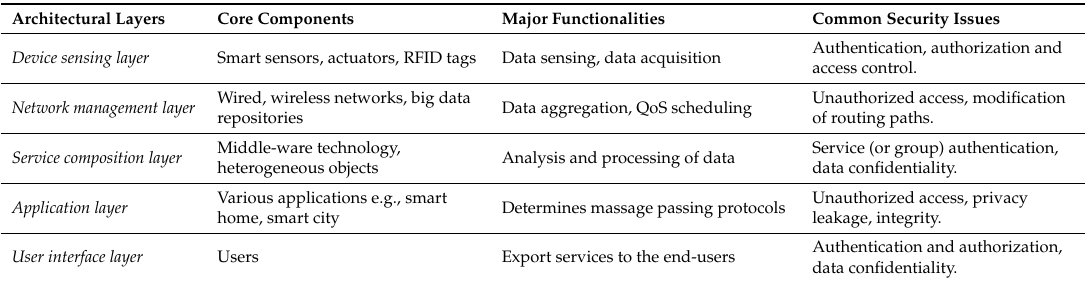
Table 1. The core components, major functionalities and common security issues for each layer of the IoT security architecture depicted in Figure